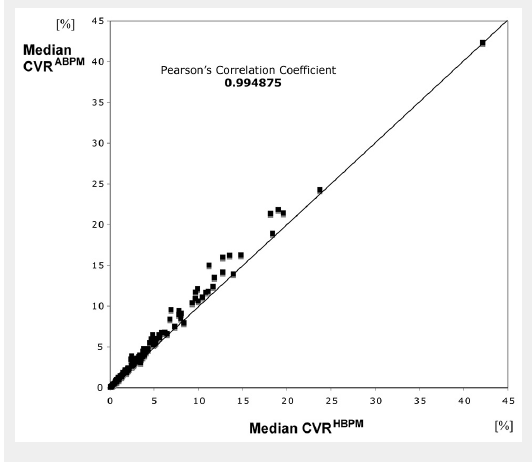
Figure 1 Correlation between CVR ABPM and CVR HBPM , calculated by use of median blood pressure levels. ABPM = ambulant blood pressure measurement; CVR = cardiovascular risk; HPBM = home blood pressure measurement